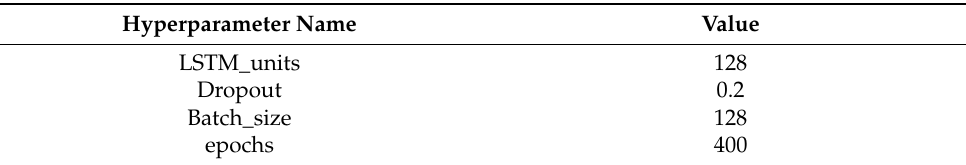
Table 4. LSTM model hyperparameter combination table.